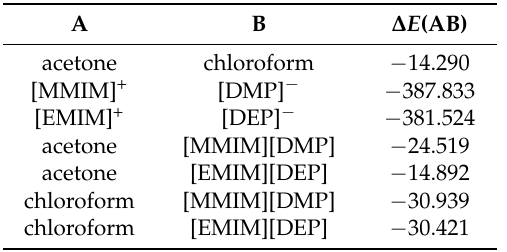
Table 2. The value ∆ E (AB) of interaction energy between ionic liquid and solvent. All energies are given in kJ · mol − 1